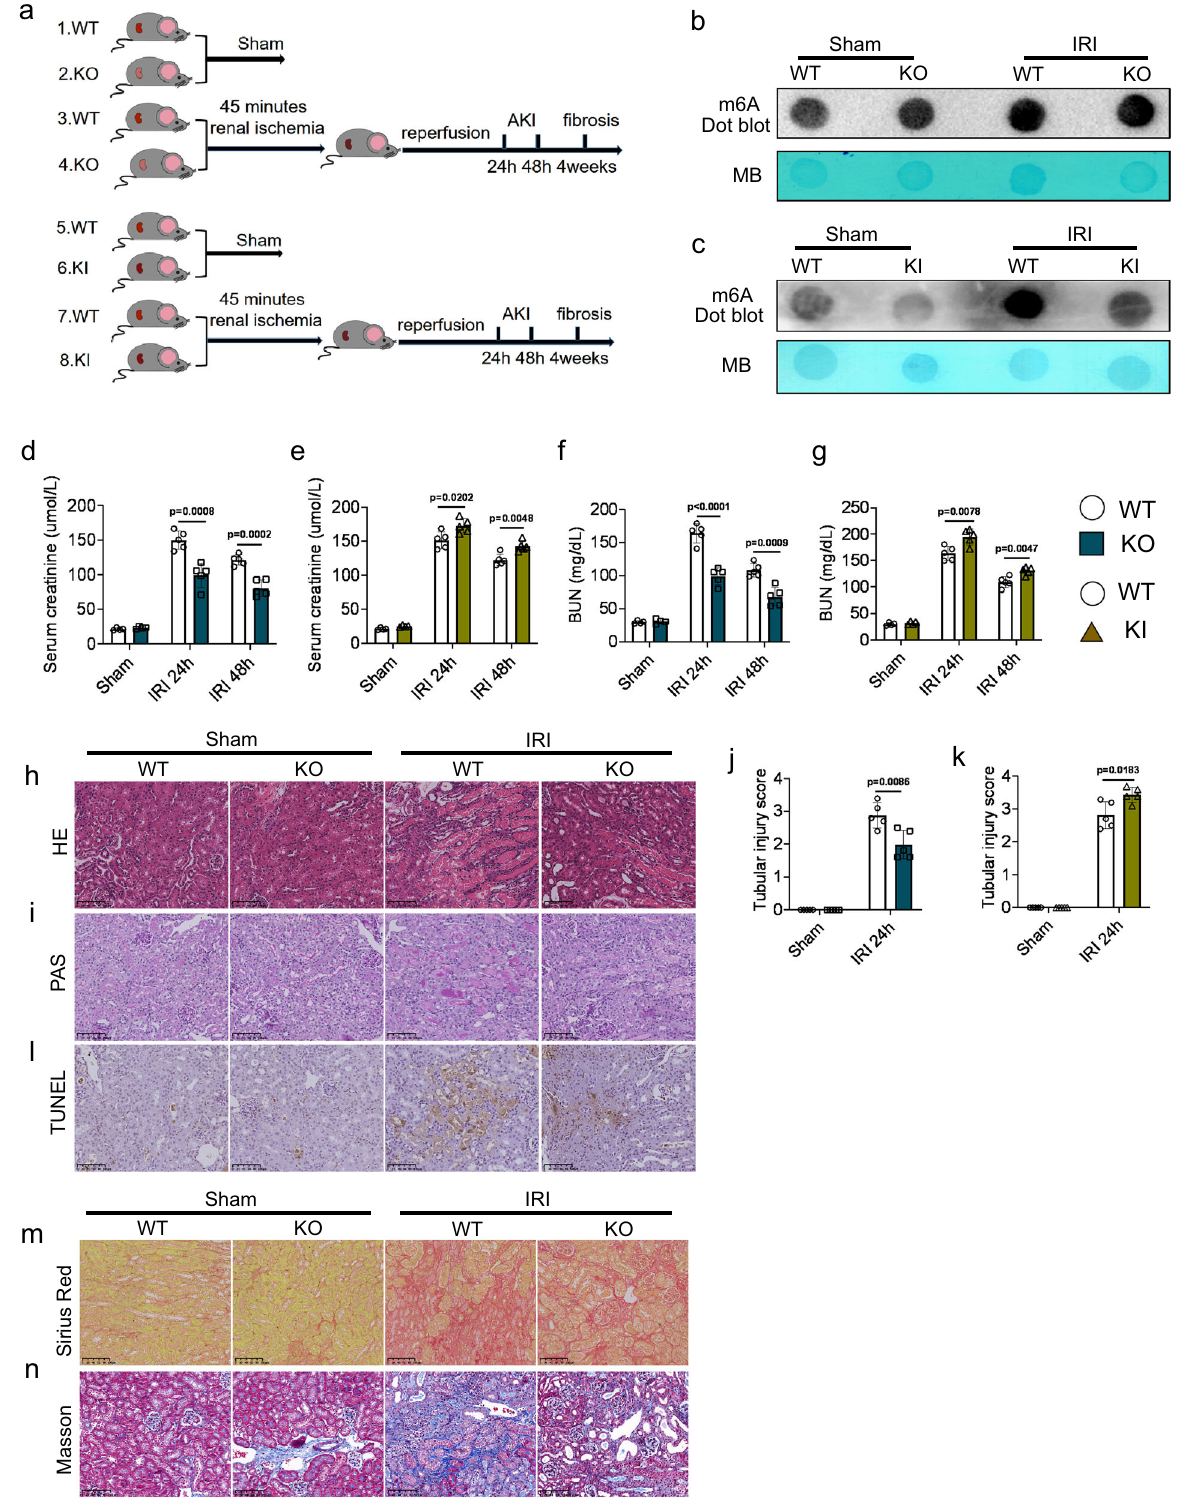
Fig. 2 | A lkbh5 de fi ciency or overexpression altered I/R-induced AKI and fi brosis. a Schematic illustrating experiment groups. b , c m6A dot blot assessed m6AmRNAmethylationofWT,KO,andKImiceinIRImodel. d – g Serumcreatinine and blood urea nitrogen (BUN) concentrations. h – k Representative hematoxylin andeosin(H&E),periodicacid – Schiff(PAS)stainingimageandtubularinjuryscore in different groups of renal tissues. l The apoptosis levels in different groups were